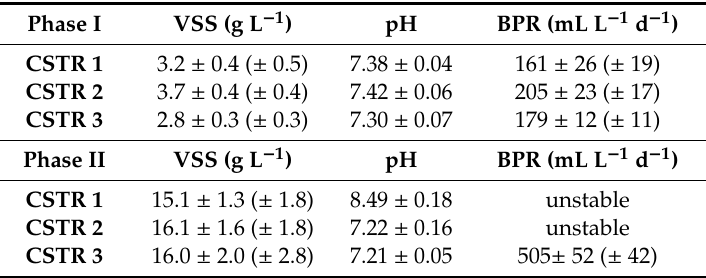
Figure 2. Biogas production rate compared to organic loading rate in three CSTRs fed on sunflower heads during operational phase I ( a ) CSTR1 (NaOH pretreated, HRT = 21 ± 7 d), ( b ) CSTR2 (NaOH pretreated, HRT = 15 ± 4 d), ( c ) CSTR3 (untreated, HRT = 16 ± 6 d) and acetic acid degradation profiles after adding acetate on the 37th day in ( d ) CSTR1, ( e ) CSTR2, ( f ) CSTR3. Table 6. Biogas production rate (BPR) and operational characteristics during the continuous mode of the three CSTRs (Mean ± SD (± CI)).